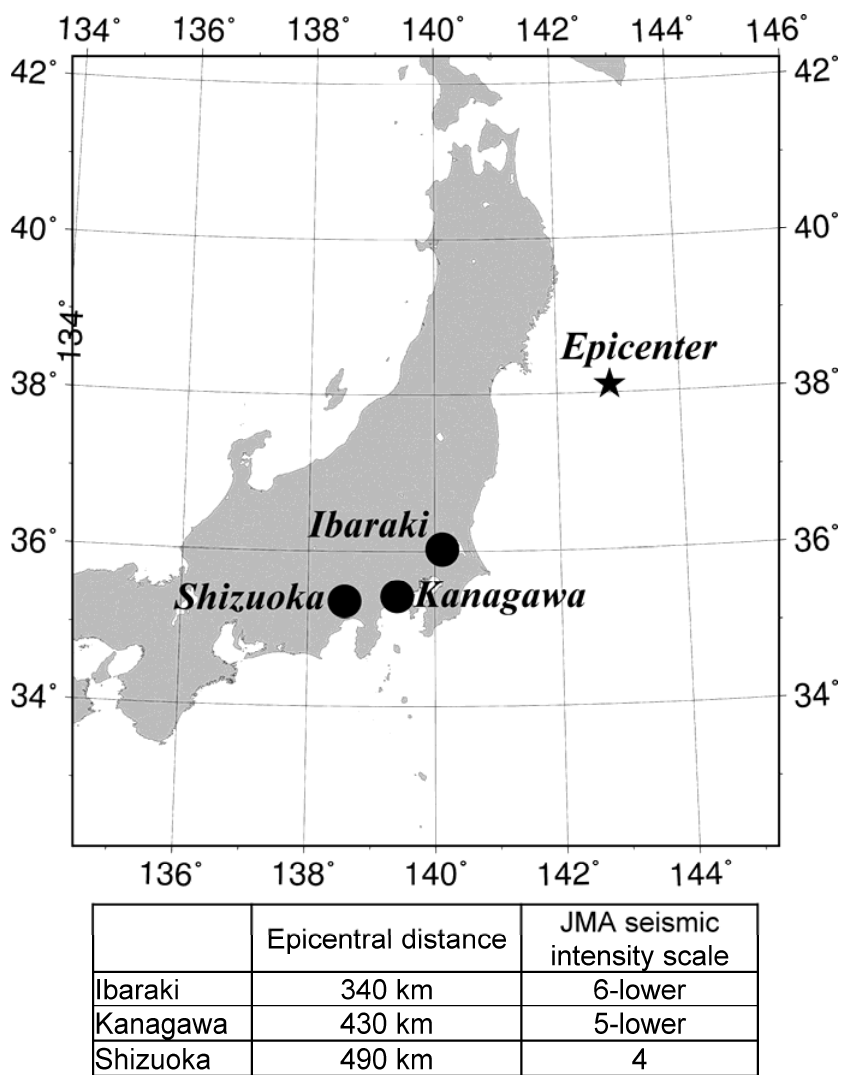
Figure 1. The epicenter of the 2011 earthquake off the Pacific coast of Tohoku, Japan. Black circles represent the approximate locations of three institutes with dairy cow milking facilities used in this study. The lower table shows the distances from the earthquake’s epicenter and approximate intensity on the Japan Meteorological Agency (JMA) seismic intensity scale of the three